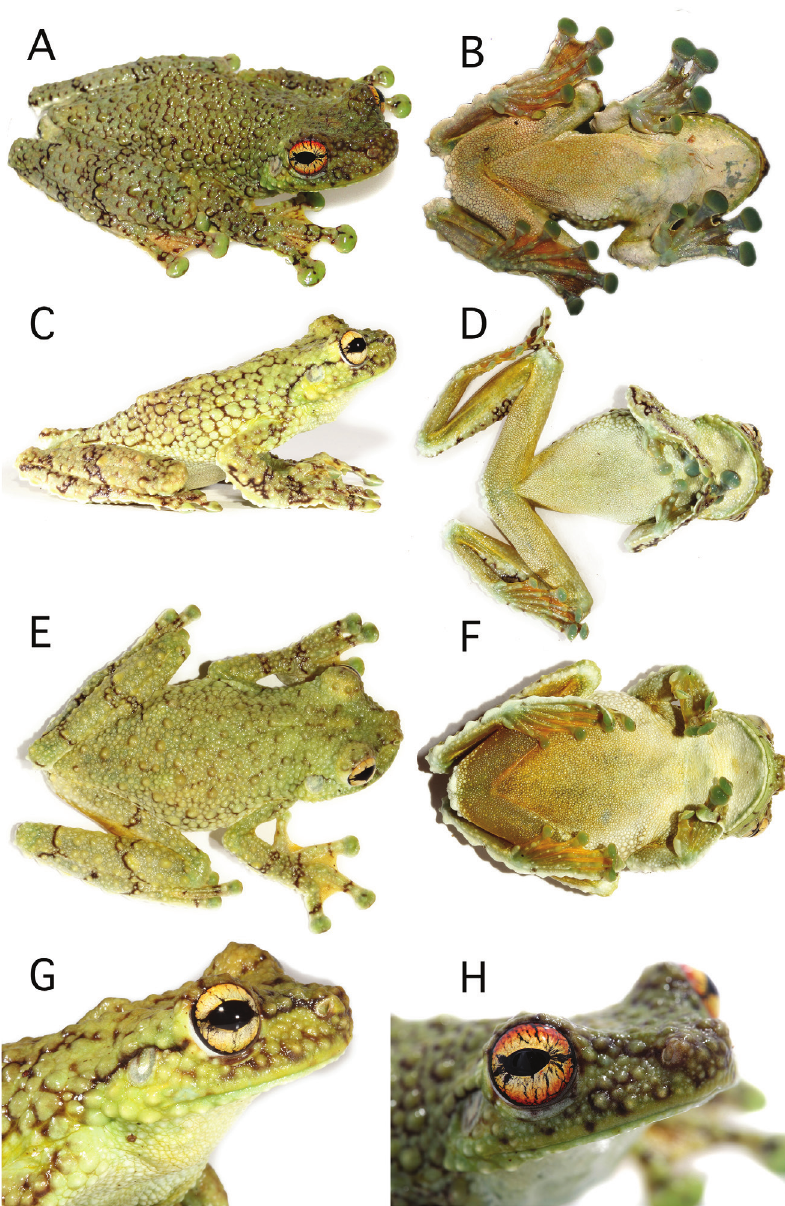
Figure 3. External morphology of Tepuihyla shushupe sp. n. and Tepuihyla tuberculosa comb. n. A–B Tepuihyla shushupe sp. n. CORBIDI 12513 (holotype), adult male, SVL = 85.3 mm, Ere river,